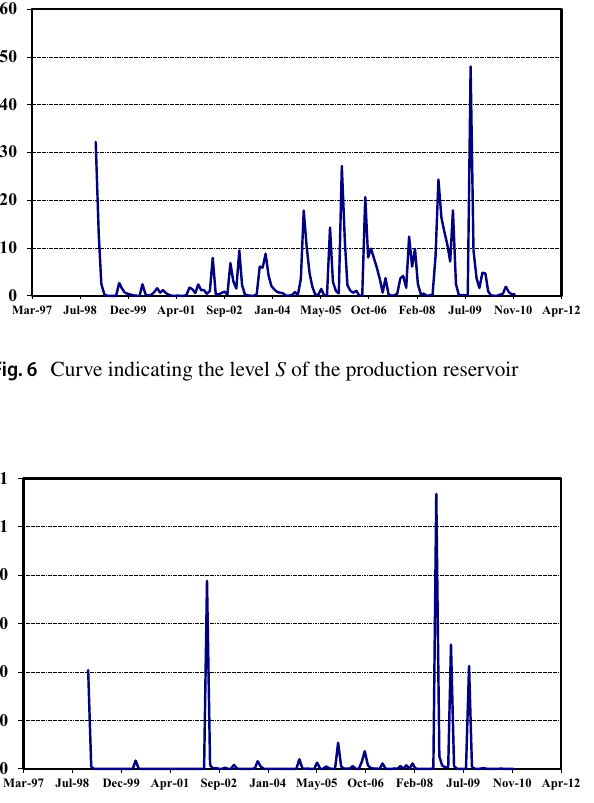
Fig. 7 Curve indicating the level R of the routing